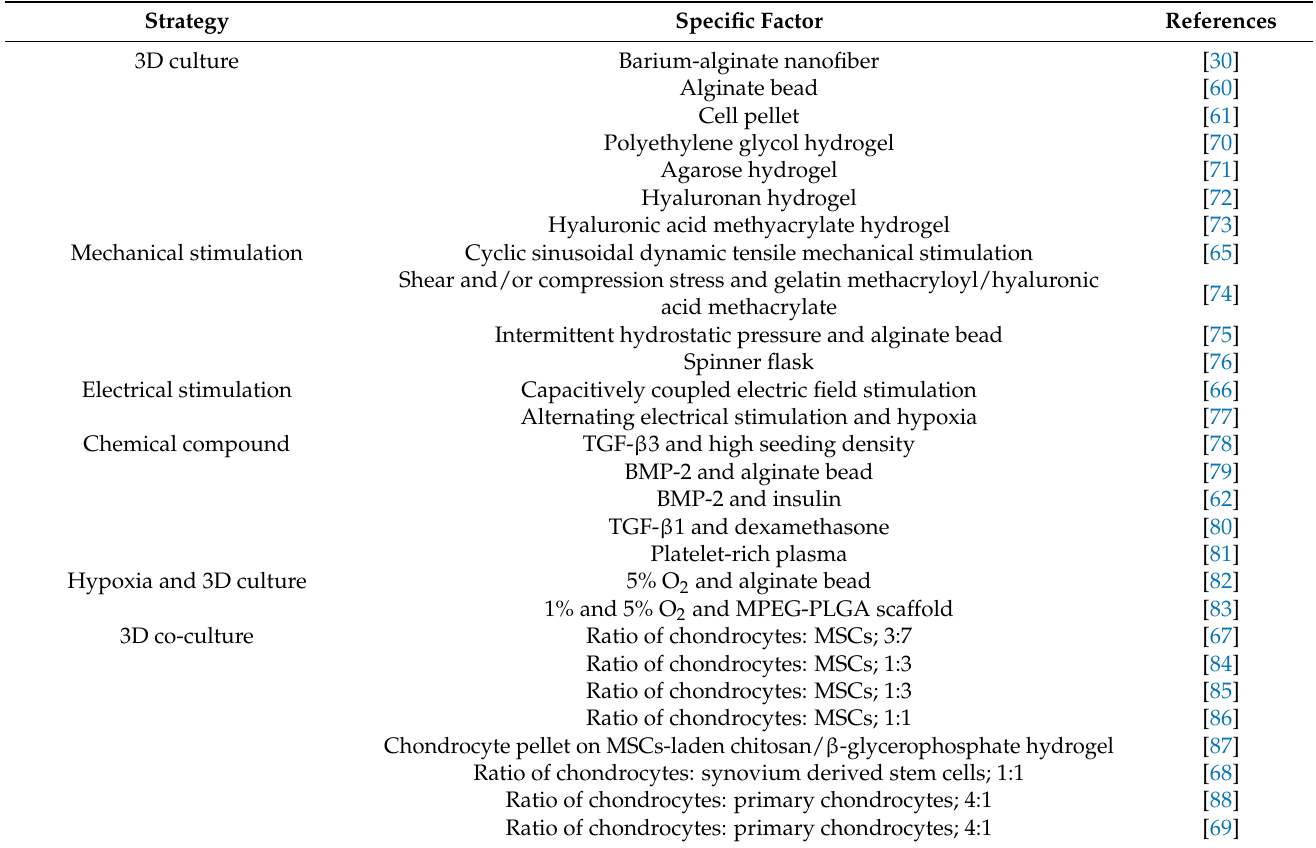
Table 4. Strategies to promote redifferentiation of dedifferentiated